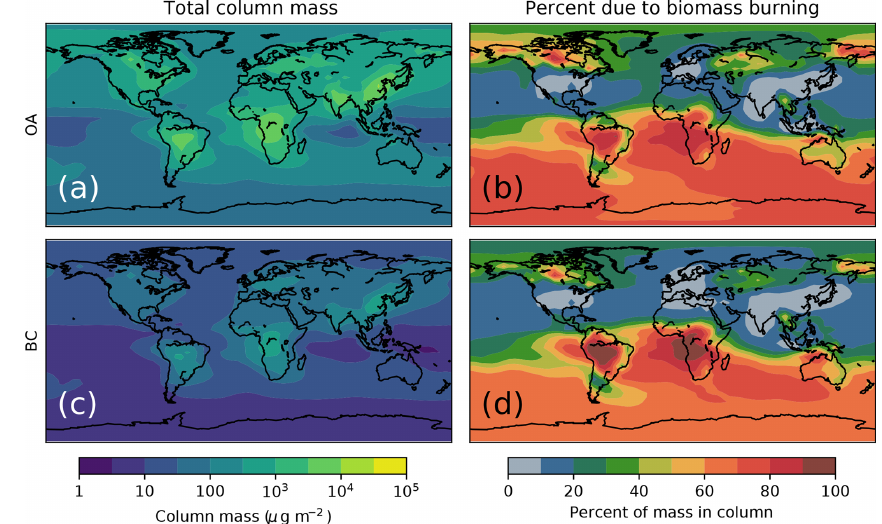
Figure 2. Effect of biomass burning on annually averaged total column OA and BC mass concentrations. The left side shows the total column mass concentration of (a) OA and (c) BC in the simulations with GFED biomass burning emissions (i.e., noSubCoag ). The right side shows the percent of the mass in the column that is due to biomass burning emissions for (b) OA and (d) BC by taking the difference between the noSubCoag and noBB simulations.